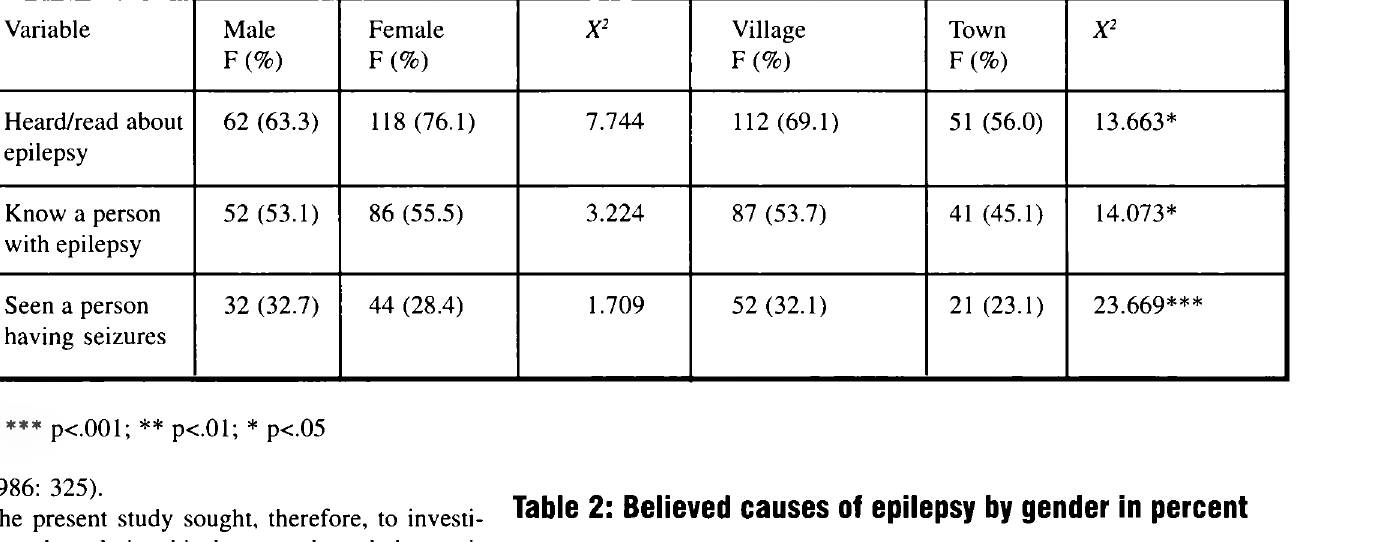
Table 2: Believed causes of epilepsy by gender in